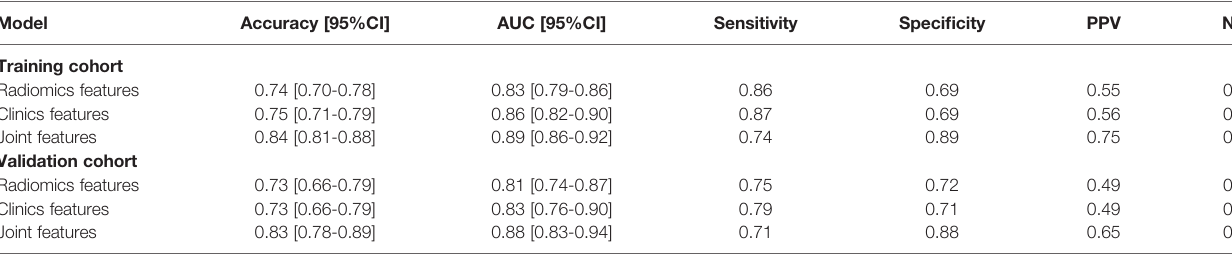
TABLE 3 | Predictive performance of the three models in the training and validation cohorts.